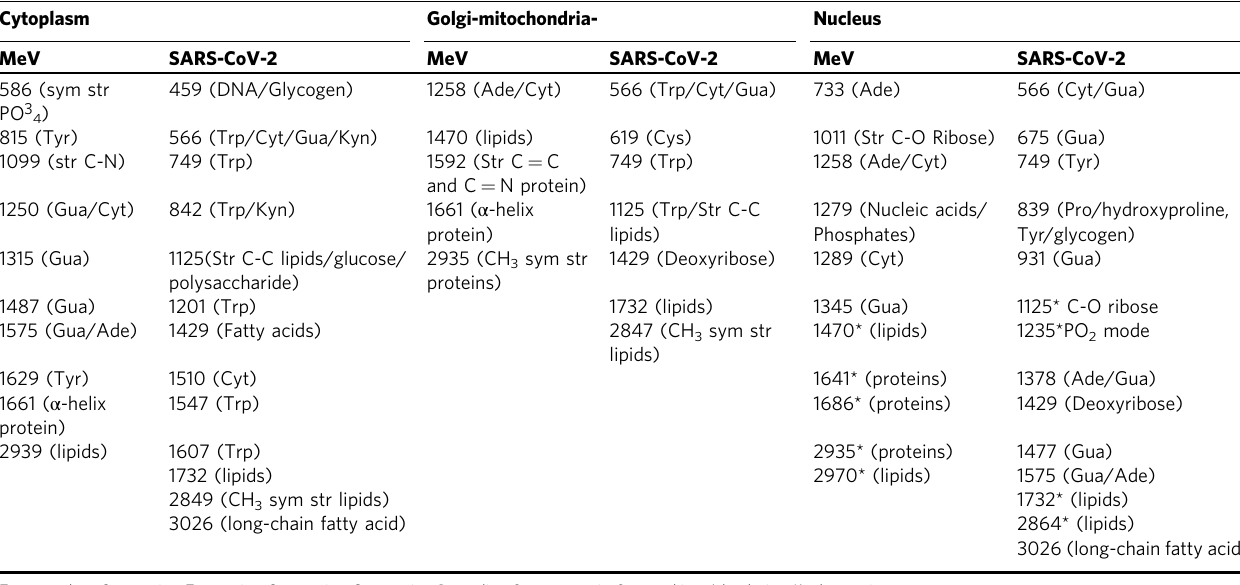
Table 1 Signi fi cant Raman peaks observed in PC loadings contributing to the separation between SARS-CoV-2 and MeV-infected Vero E6 cells 24 – 26,33,53,60